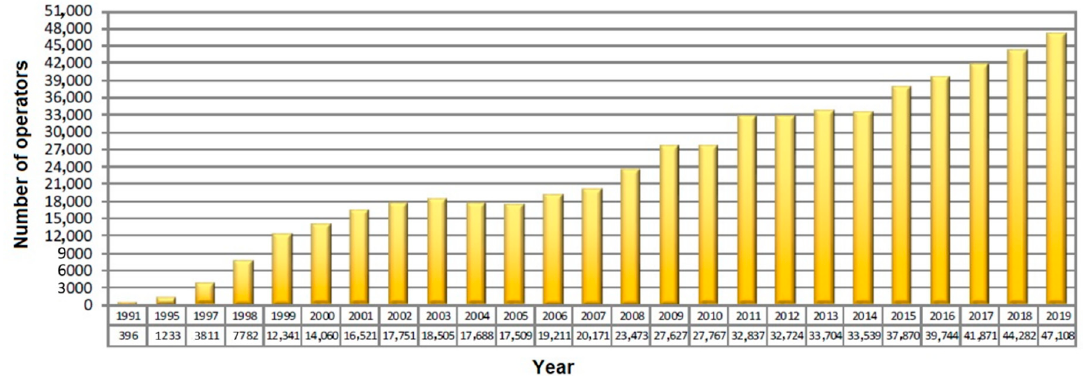
Figure 1. The development of organic production (1991–2019). Source: Ministry of Agriculture, Fisheries and Food (2020).